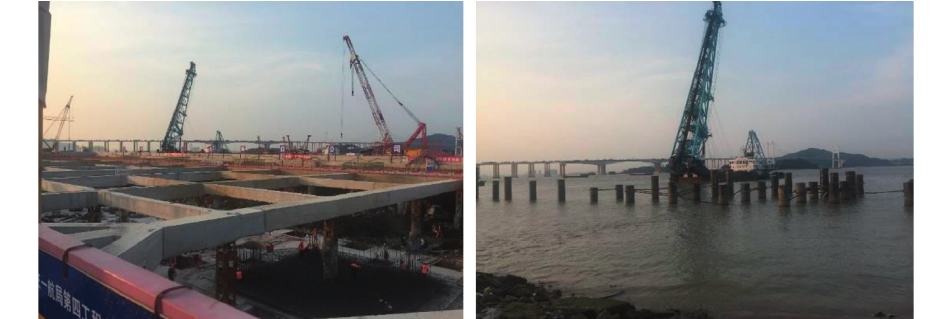
Figure 11: Construction site map of the